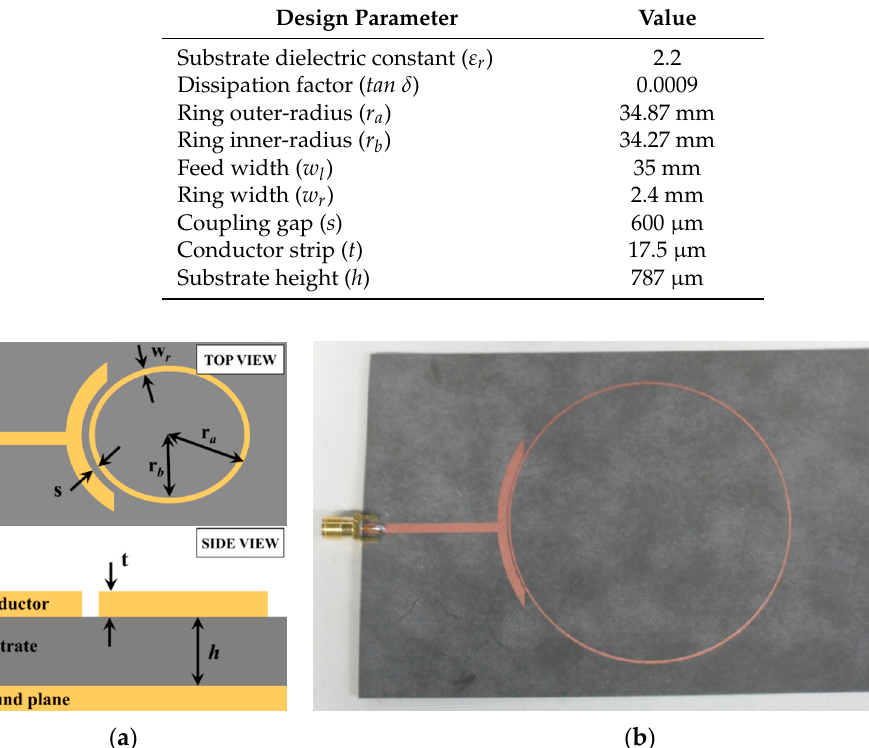
Figure 2. Highly sensitive microwave ring-resonator sensor. ( a ) Illustration; ( b ) Fabricated prototype.